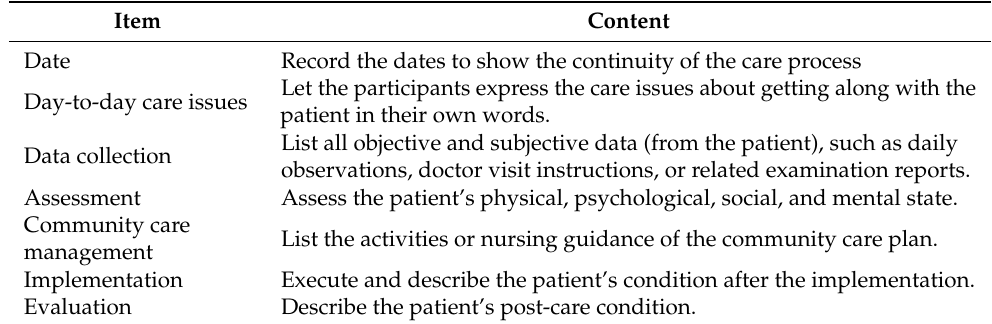
Table 1. Contents in the research log of the family interaction